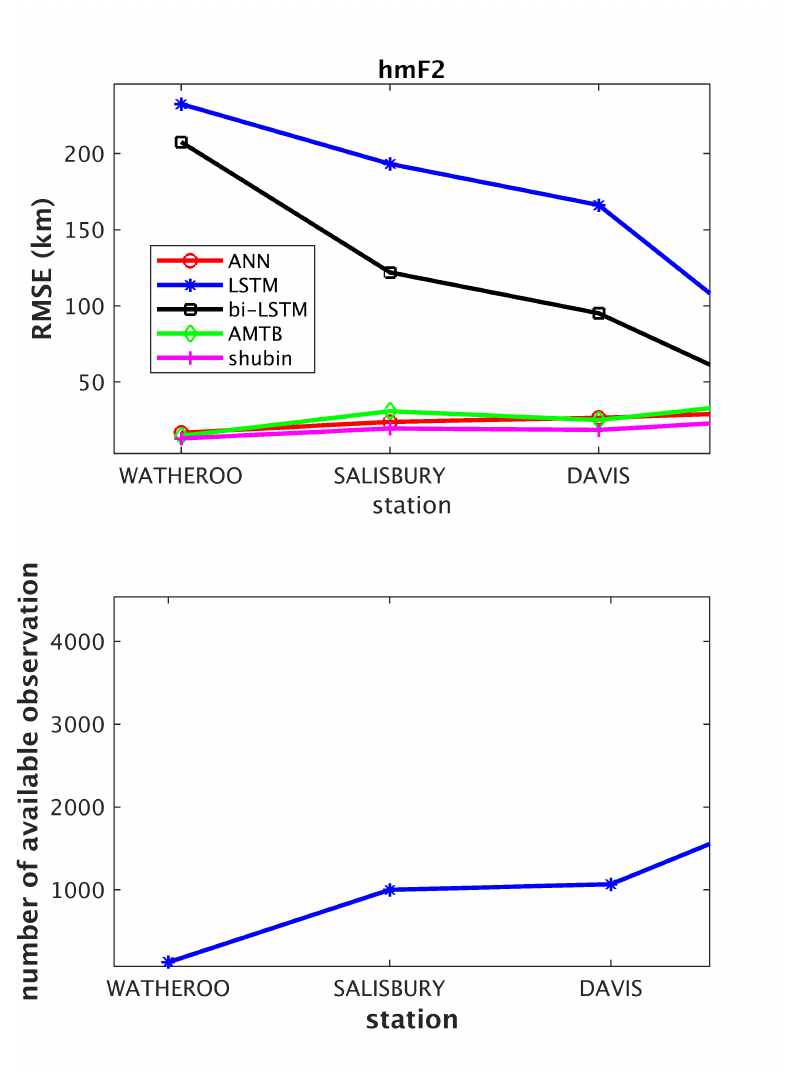
Figure 7. ( a ) RMS for each of the five models in the three discarded stations (the models of this figure is developed by using the initial/default configuration, different from Figure 6); and ( b ) the number of sample sets in each discarded